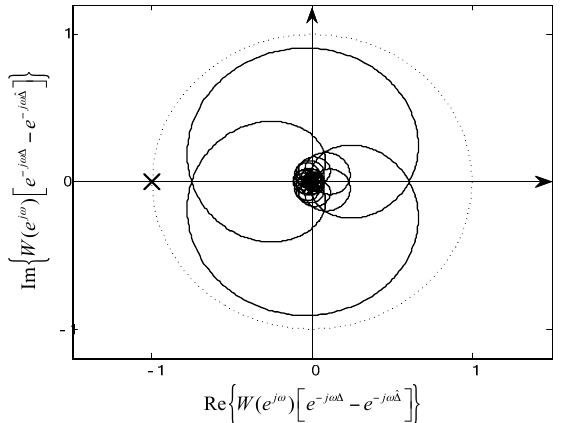
e        (solid line) is drawn in Figure 2. An example showing that a Nyquist plot of W ( e j ω )[ e − j ω ∆ − e − j ω ˆ ∆ ] (solid line) is drawn in the unit circle (dotted line). The ‘ × ’ mark represents the Nyquist point ( − 1, the unit circle (dotted line). The ‘×’ mark represents the Nyquist point ( − 1, 0).